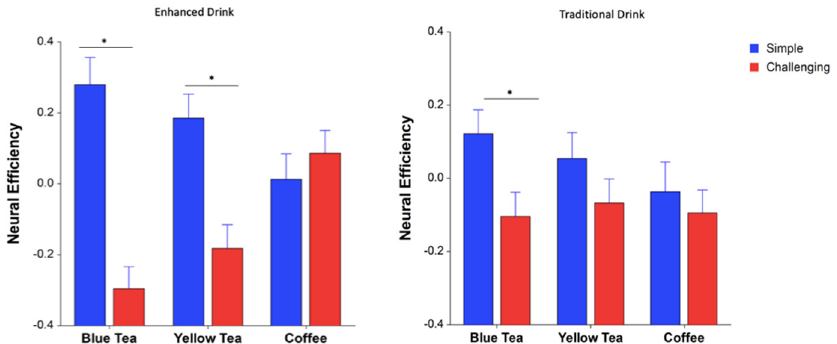
Figure 8. Arousal levels during drink consumption. Whiskers represent the SEM.